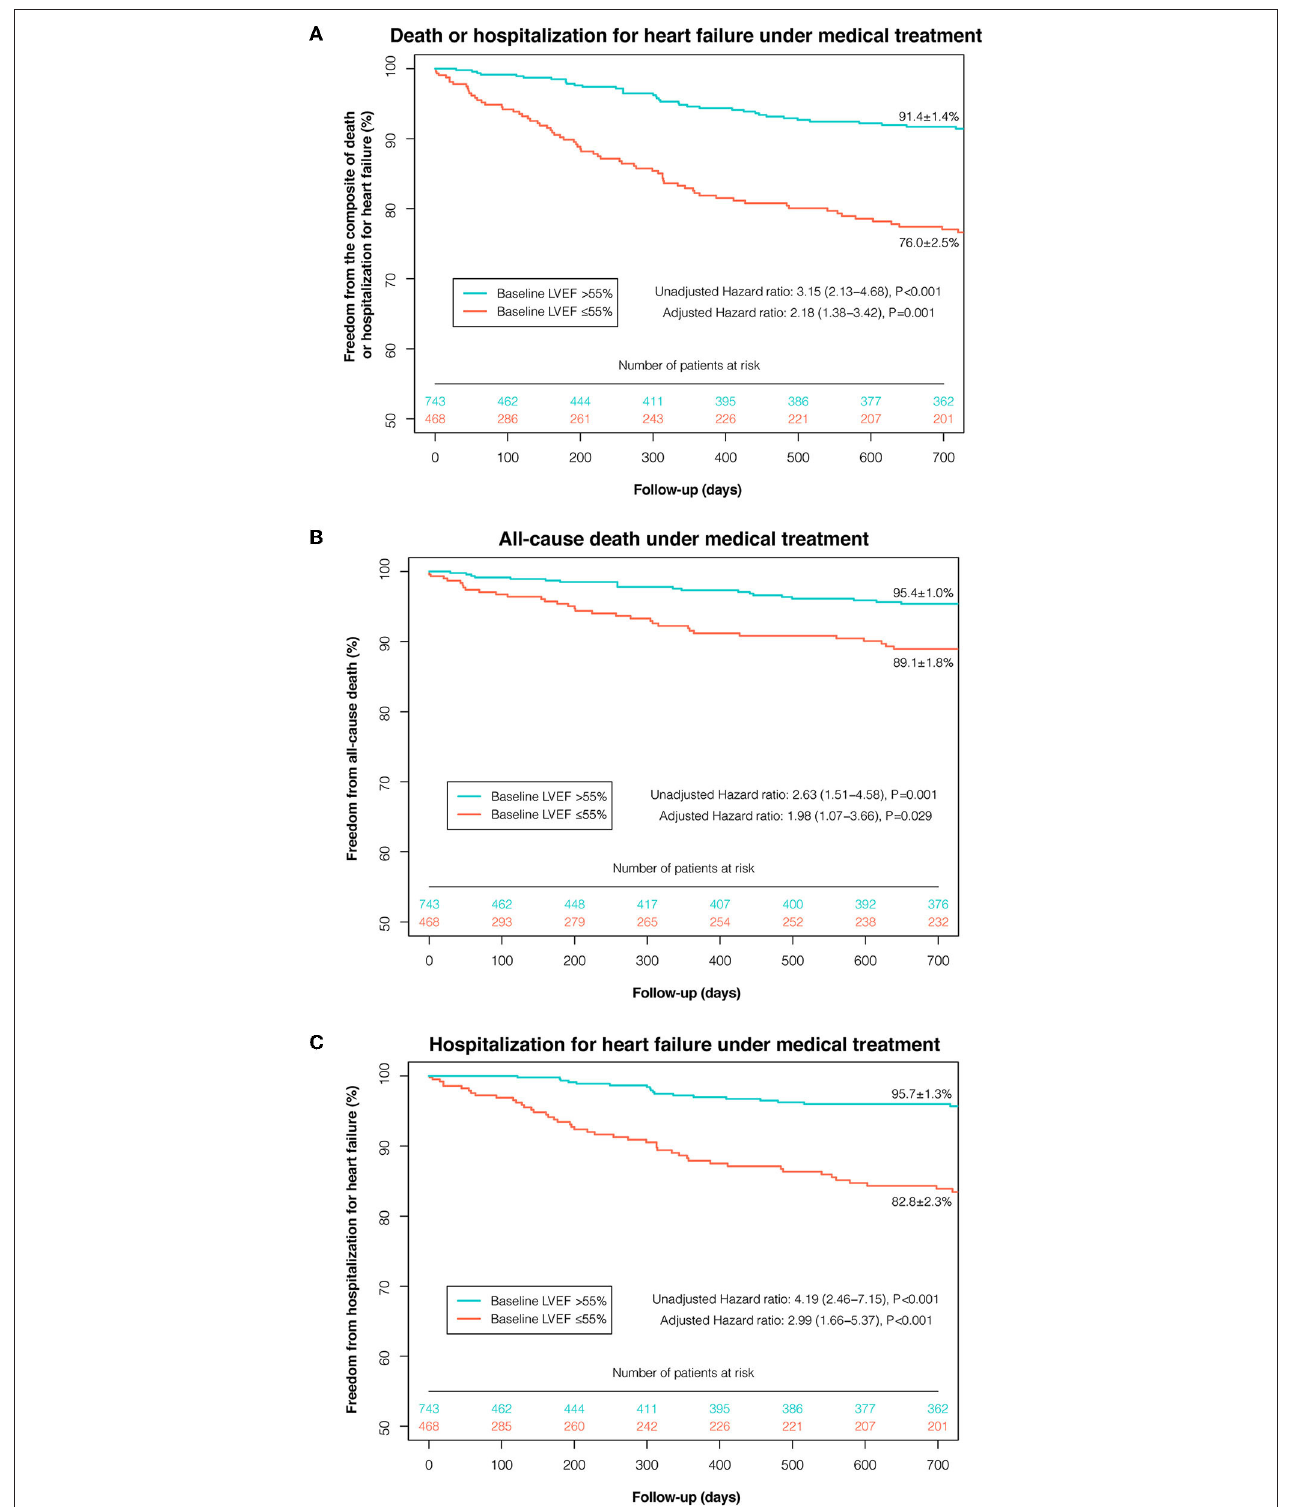
FIGURE 2 | Kaplan-Meier curves of event-free survival under medical treatment according to the selected LVEF threshold. Kaplan-Meier curves of freedom from the composite of death or HHF (A) , death (B) , and HHF (C) under medical treatment were plotted according to the selected LVEF threshold ( ≤ 55 and > 55%). AVI, aortic valve intervention; HHF, hospitalization for heart failure; LVEF, left ventricular ejection fraction.